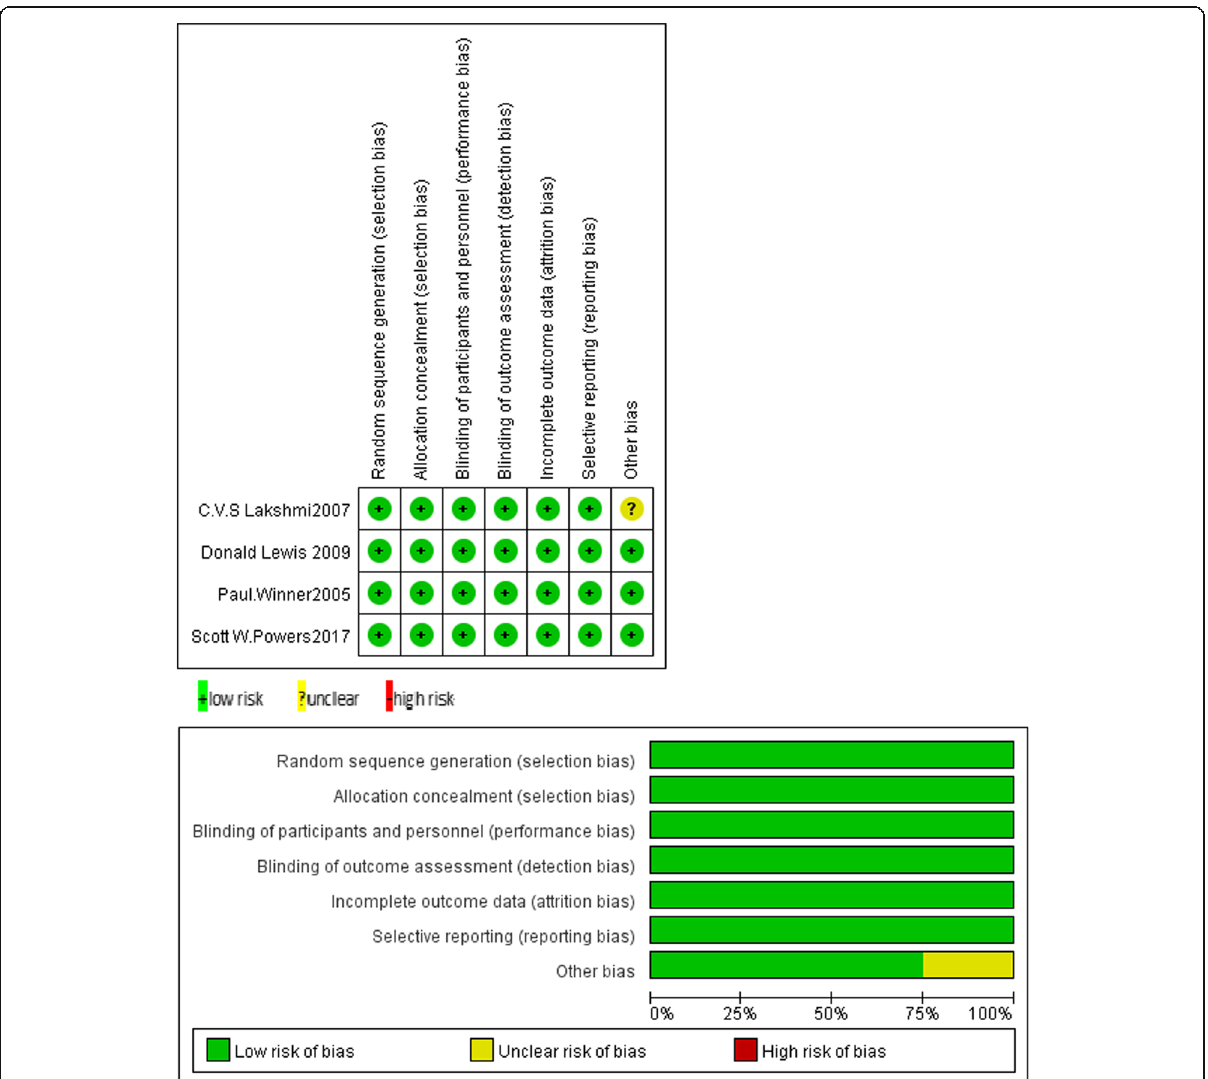
Fig. 2 Risk of bias summary. Presentation of the risk of bias summary of the review authors